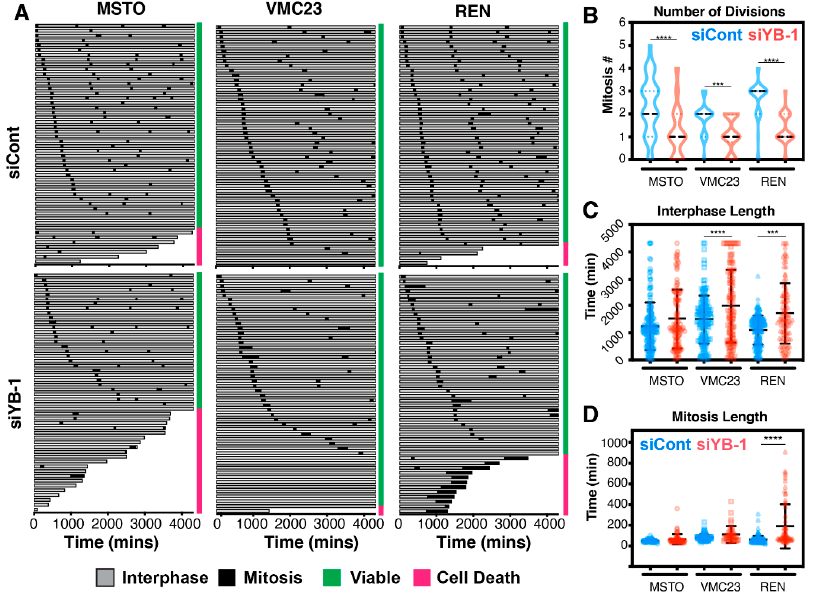
Figure 7. Multigenerational cell fate mapping analysis reveals three distinct phenotypic changes in MPM cells after YB-1 knockdown. ( A ) Multi-generational cell fate maps of 50 individual cells from three MPM cells transfected with 5 nM Control (siCont) or YB-1 siRNA #1 (siYB-1). Cells were transfected, incubated overnight and seeded for videos, which ran for 72 h. Time spent in interphase (grey), mitosis (black), viable cells (green bar) and cells that die (pink bar) are shown. ( B ) Violin plots of total number of divisions within in the 72-h period. Mean divisions (black dotted bar). ( C , D ) Dot plots of total time (mins) spent in interphase (grey bars) and mitosis (black bars) for each individual cell across each MPM cell line shown in ( A ). *** p < 0.001, **** p < 0.0001.